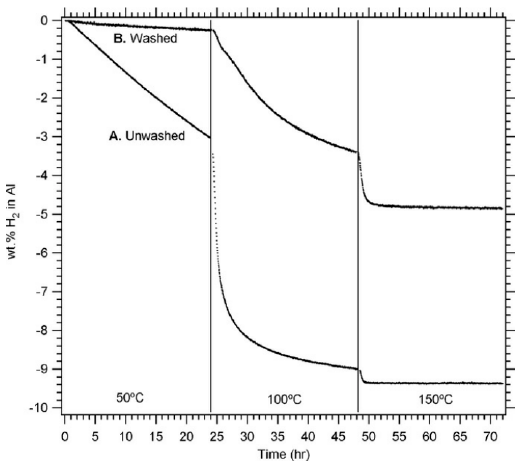
Figure 6. Hydrogen desorption data from ( A ) unwashed and ( B ) washed samples cryogenically milled for 1 h with a 2:1 LiCl:AlH 3 volume ratio. Reprinted with permission from ref. [52]. Copyright 2009 Elsevier.